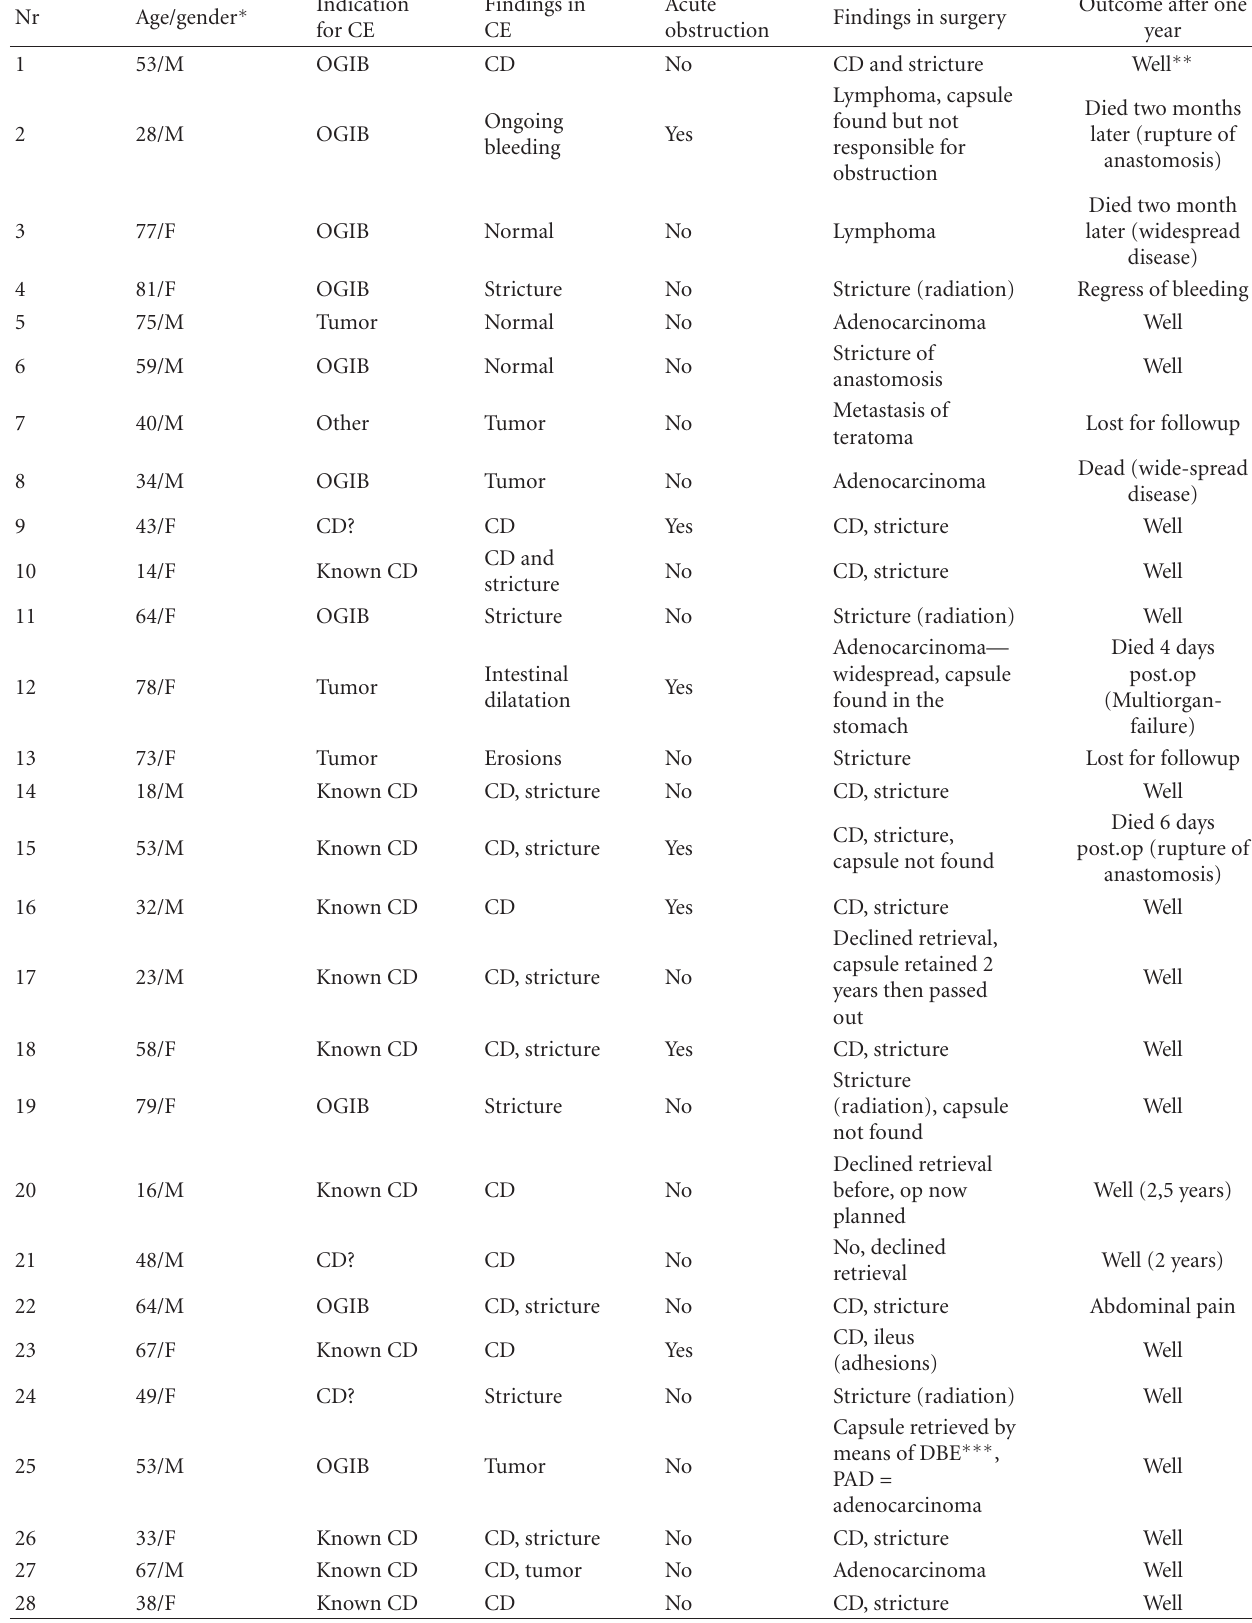
Table 2: Patients with capsule